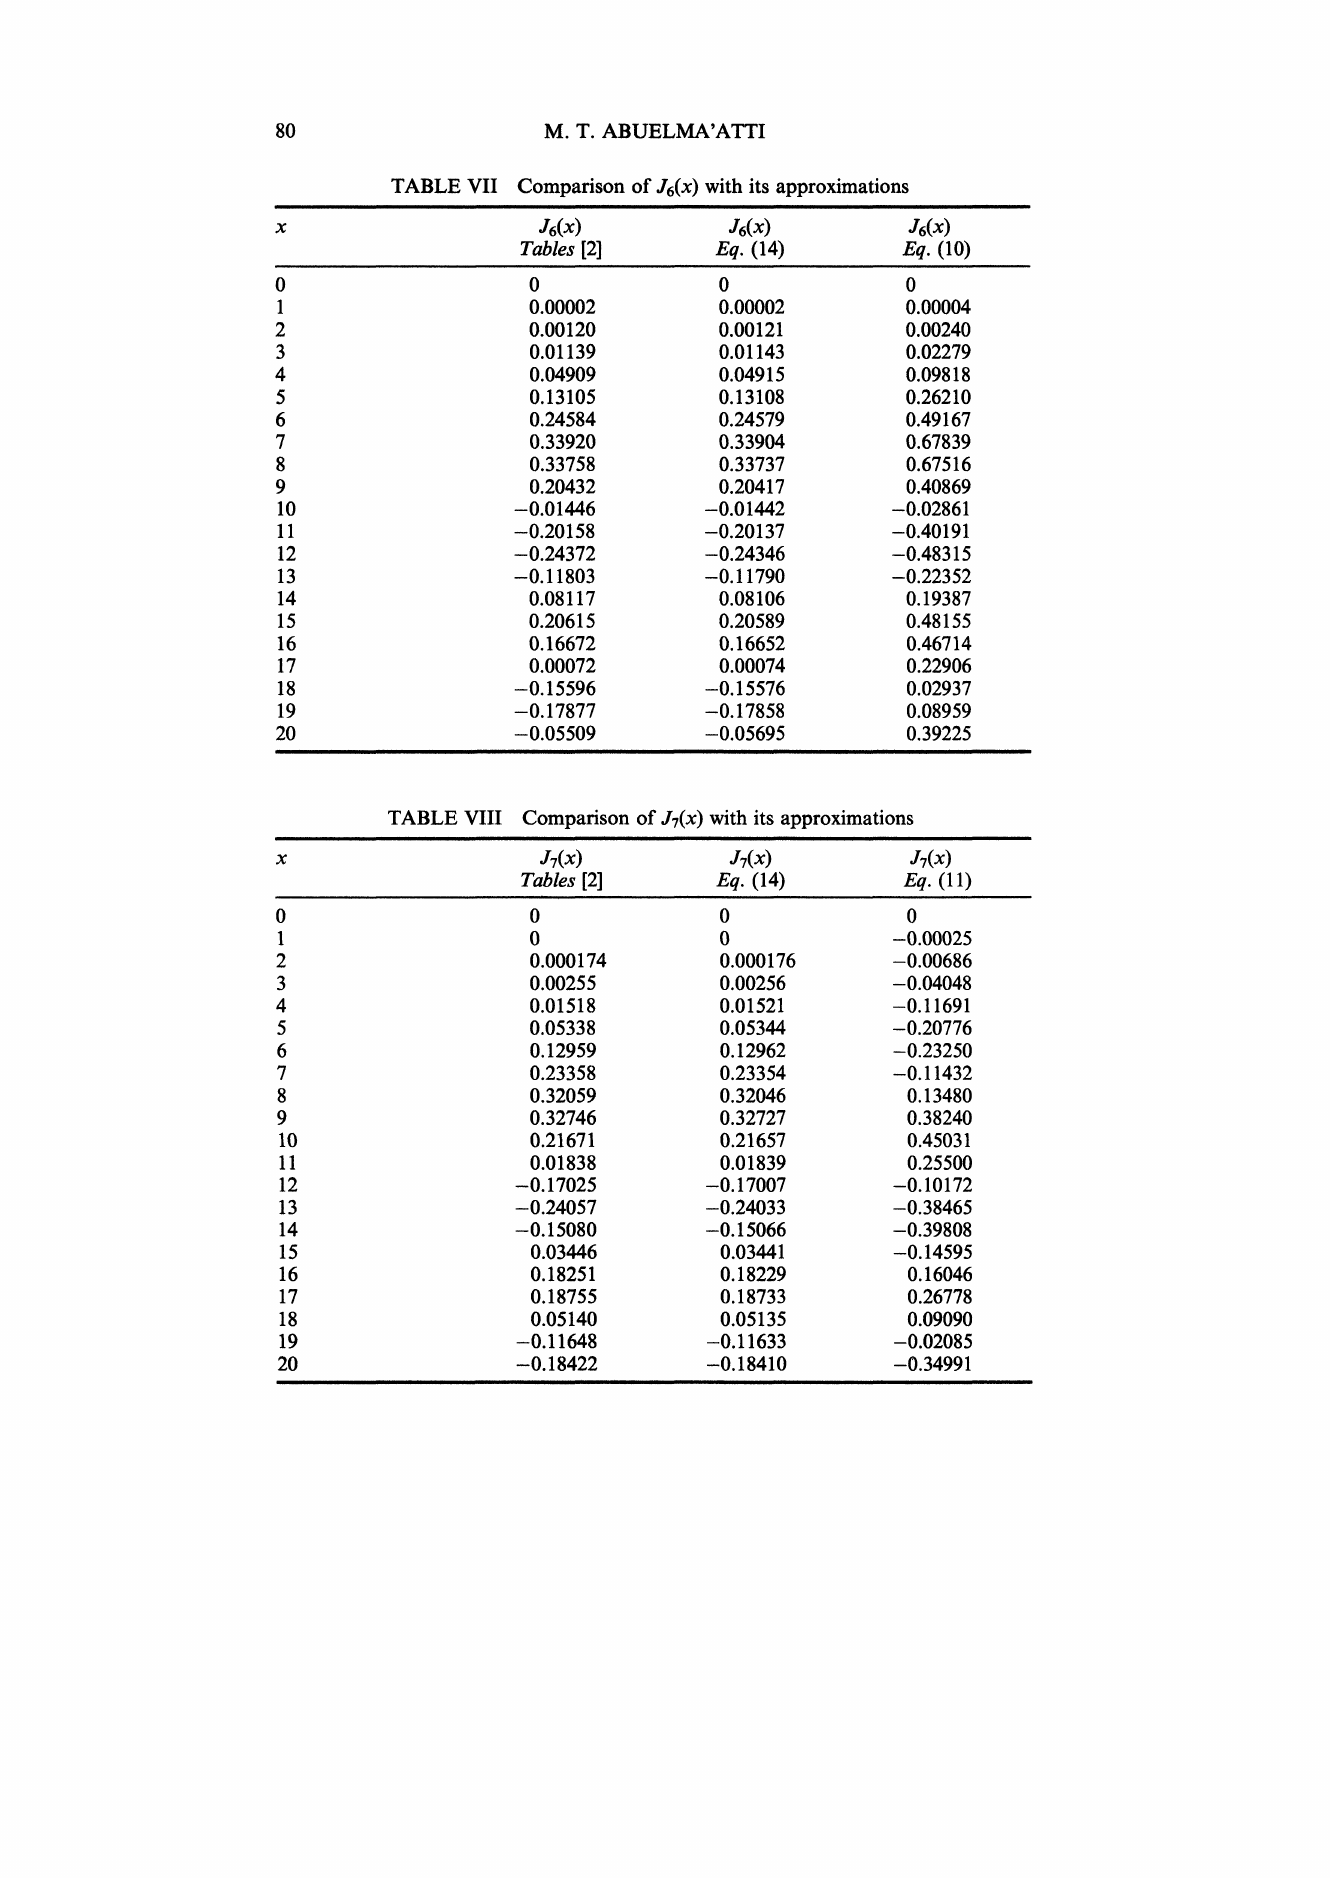
TABLE VII Comparison of J6(x) with its approximations